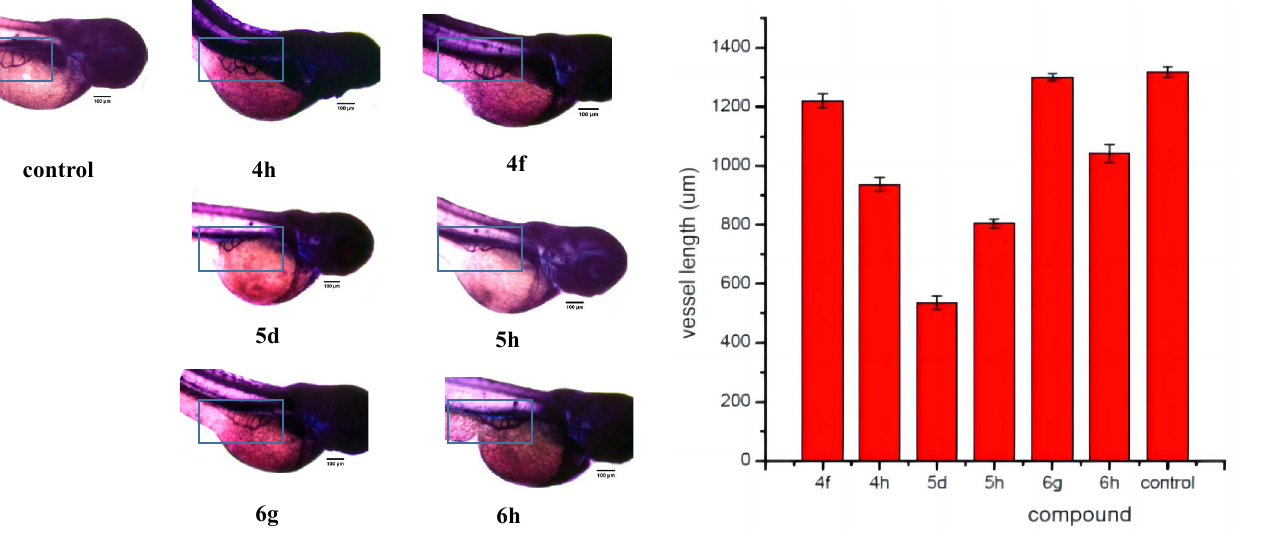
Figure 12. Effects of representative compounds ( 4f, 4h, 5d, 5h , 6g and 6h ) and control on the subintestinal veins (SIVs) length of 72 hpf zebrafish embryos (x ± s, n = 12), p <